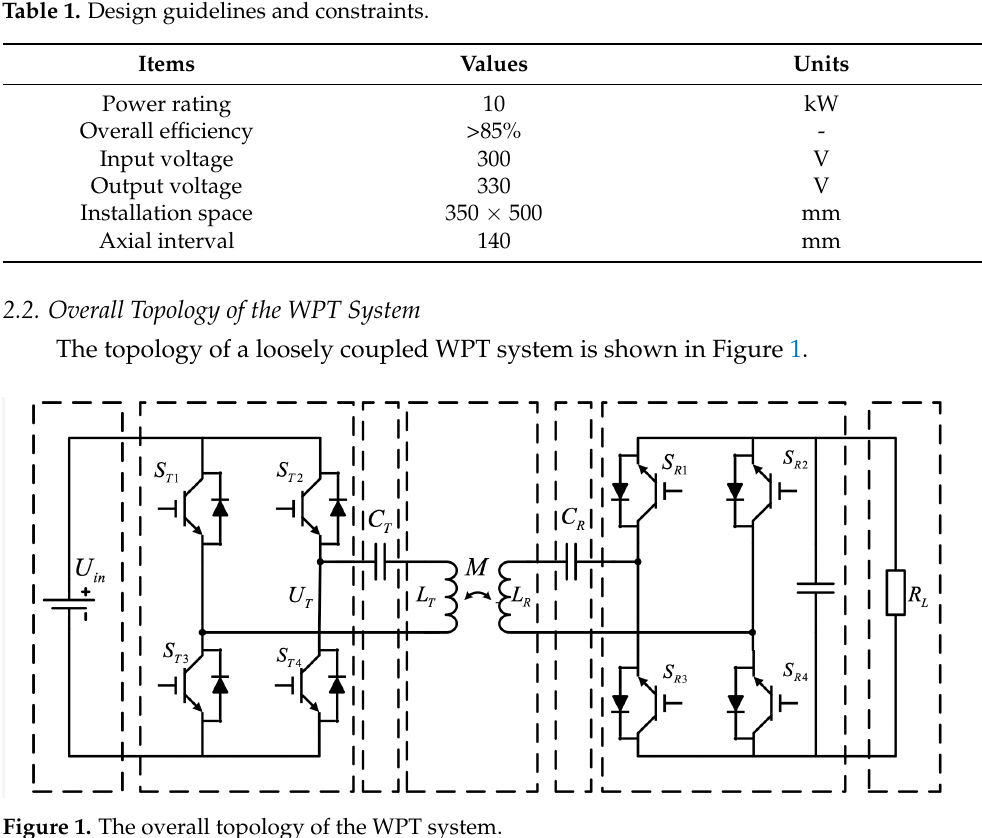
Figure 1. The overall topology of the WPT